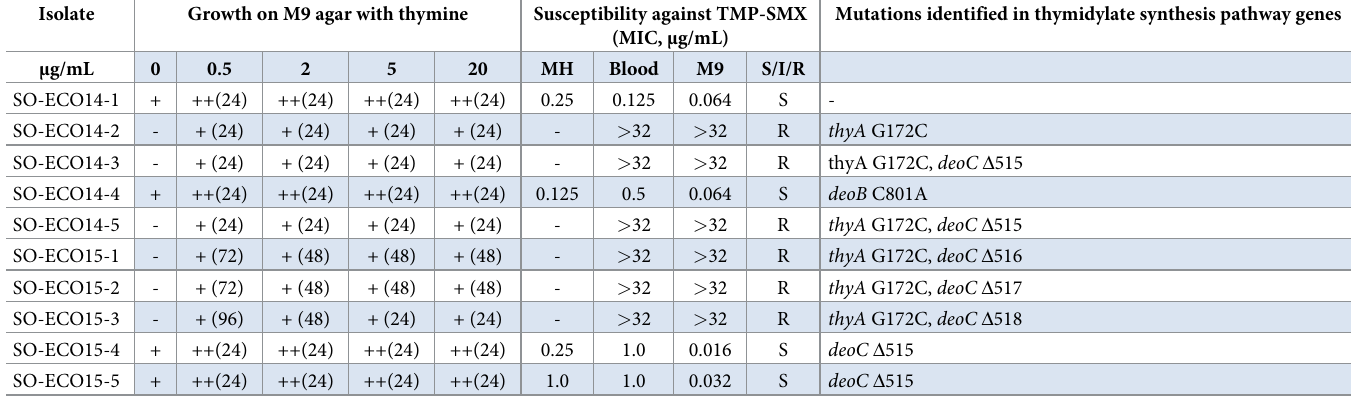
Table 2. Growth characteristics and antimicrobial susceptibility of E . coli isolates. Normal growth designated as “++”, scarce growth with small colonies designated as “+”, with required incubation time for colonies to appear indicated in parentheses and “-”indicates no growth. Antimicrobial susceptibility (MIC) against TMP-SMX ( μ g/ mL) was performed on M9 agar media with added thymine concentrations 0.5,2,5 and 20 μ g/ml and average MIC values are reported. Mutations identified in thymidylate synthase pathway genes by whole genome sequencing are